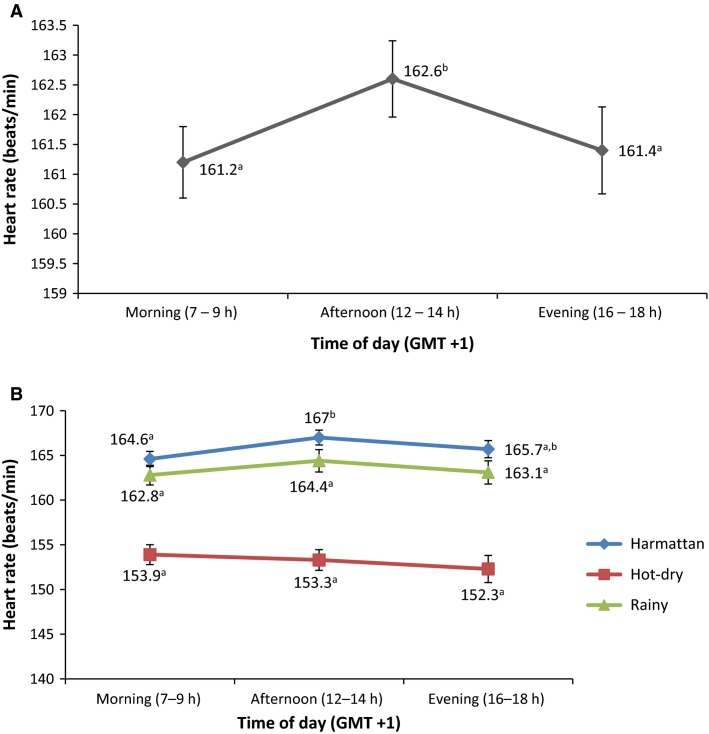
Overall (A) and across season (B) diurnal variations in heart rate of African giant rats (Cricetomys gambianus, Waterhouse). Subject numbers (n) are reported in Table1. Mean (± SEM) values in the same series with different and/or not sharing superscript letters (a,b) are significantly (P < 0.05) different.